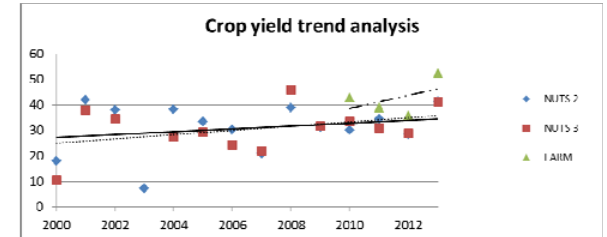
Figure 2. Official statistics on winter wheat crop yield for region, county scale and field based crop yield